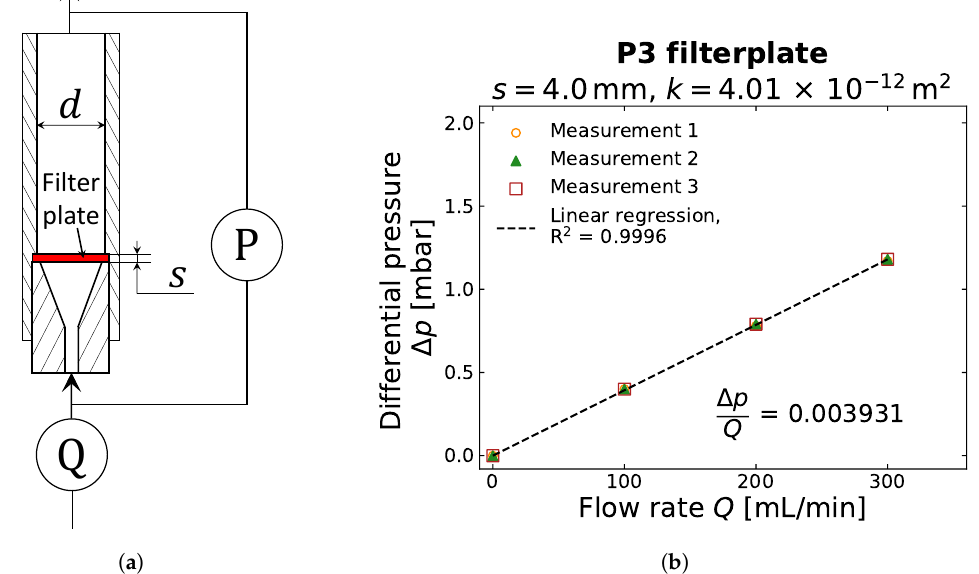
Figure A1. ( a ) Sketch of the gas permeameter set-up with a fixed filter plate (thickness s = 4mm) in red and diameter d = 31mm. The remaining dimensions of the sample holder are shown in Figure 1. Dry nitrogen was flown through the sample at a fixed flow rate Q set by the flow controller Q through filter plate. The pressure transducer P monitored the pressure difference ∆ p over the filter plate. ( b ) Measured differential pressure versus flow rate for a dry P3 filter plate. The slope of the linear regression between ∆ p and Q was used to obtain the permeability using Equation